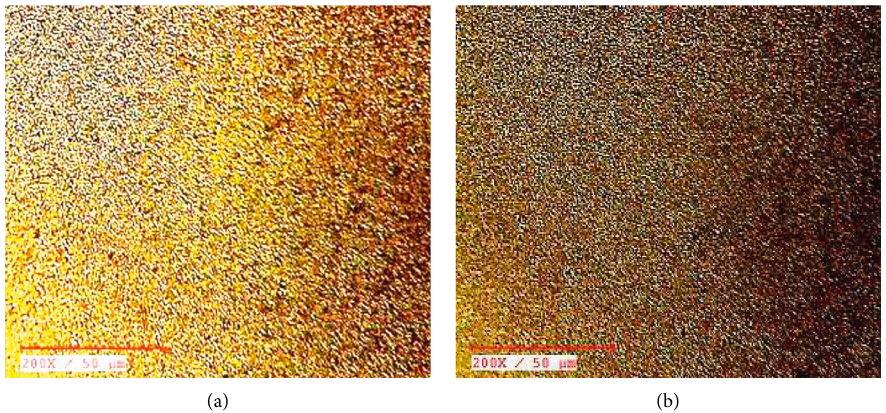
Figure 5: Microstructure of the NZ (a) at 0 ° tool angle and (b) at 1.5 ° tool